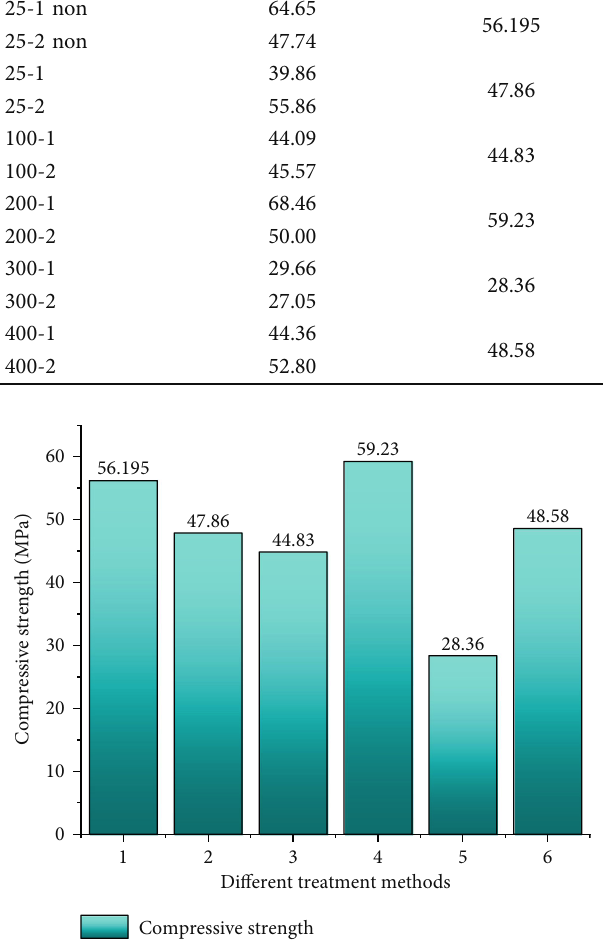
Figure 5: The statistical graph of the compressive strength of rock samples after various treatments. Table 2: Tensile strength data of di ff erent specimens.